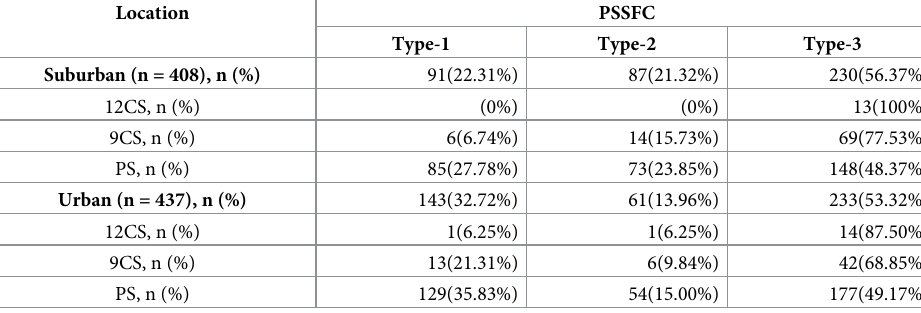
Table 5. Numeric statistics on 3 types of PSSFC clustered by using machine